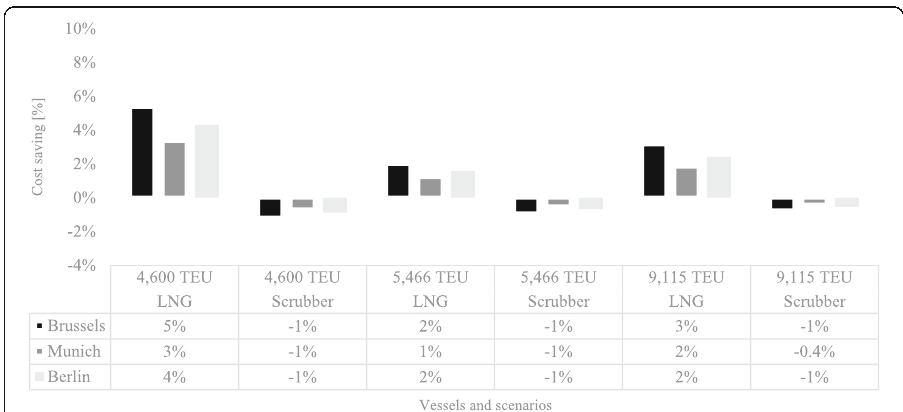
Fig. 9 Relative changes for supply chain cost from Jacksonville to EU for different ship types and for LNG and scrubber scenarios